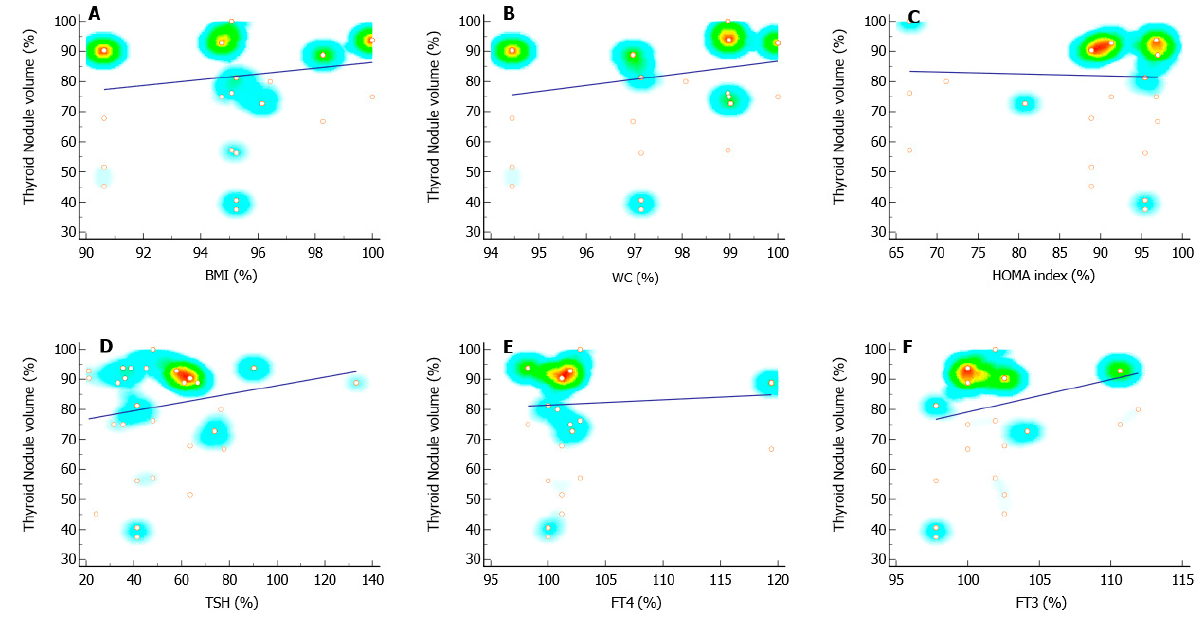
Figure 4. Scatter plots and regression lines of the ratio of the nodule volume. Panels ( A – C ) indicate the values distribution and regression line of the ratio of the thyroid nodule volume (%) and the ratio of the body mass index (BMI) ( A ), the waist circumference ( B ), and the homeostatic model assessment (HOMA) index ( C ). Panels ( D – F ) indicate the values distribution and regression line of the ratio of the thyroid nodule volume (%) and the ratio of thyroid-stimulating hormone (TSH) ( D ), thyroxin (FT4) ( E ), and free-triiodothyronine (FT3) ( F ). The ratio of each variable was calculated using the following formula: [(after value/before value) × 100]. Table 3. Multiregression analysis of thyroid nodule volume.